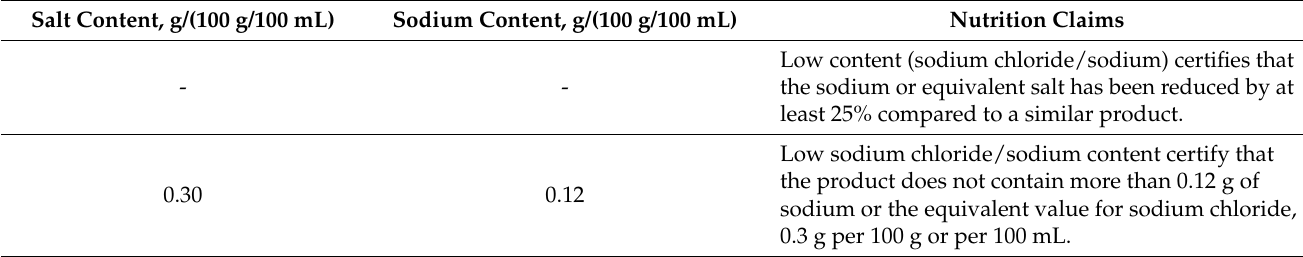
Table 1. Nutrition claims regarding salt/sodium content—per Article 8 of EU Regulation 1924/2006 [1,5]. Salt Content, g/(100 g/100